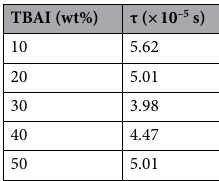
Table 5. Relaxation time for PUA-TBAI-I 2 GPE system at room temperature.